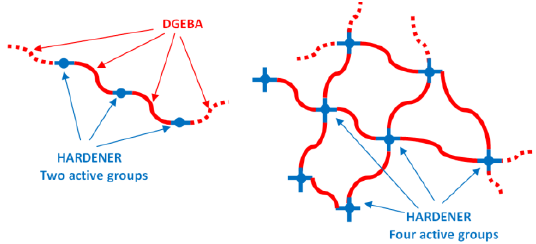
Figure 8. A hardener having only two active sites is not able to generate a solid material. A rigid material is linked to hardener having a number of active groups greater than two. Insulation wall must be as hard as possible.